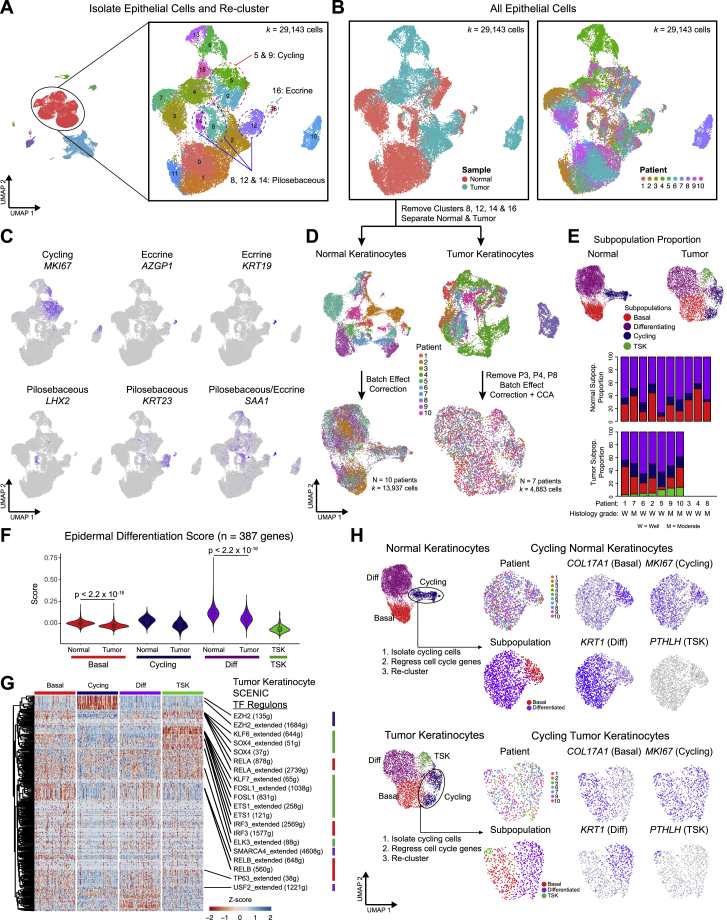
Keratinocyte Annotation and Subpopulation Analysis, Related to Figure 2(A) UMAP of all epithelial cell clusters (k = 29,143) with labeled cycling, eccrine cell, and pilosebaceous clusters. (B) UMAP of all epithelial cells labeled by tissue type and patient. (C) UMAP feature plots of expression of genes marking cycling, eccrine, or pilosebaceous clusters. (D) UMAPs of filtered normal and tumor keratinocytes labeled by patient before and after batch correction. CCA = canonical correlation analysis. (E) Bar plots showing proportion of each subpopulation across normal and tumor keratinocytes. (F) Violin plots of differentiation signature score (n = 387 genes, Lopez-Pajares et al., 2015) in normal and tumor keratinocyte subpopulations. p values were determined with pairwise Wilcoxon Rank Sum tests with Benjamini-Hochberg correction for multiple comparisons. (G) Clustered heatmap of all recovered transcription factor (TF) regulons from SCENIC analysis (n = 370 regulons) across tumor keratinocyte subpopulations. For visualization purposes, 100 random cells from each subpopulation are shown in the heatmap. (H) Cell cycle regression analysis with re-clustering into basal, differentiating, and TSK subpopulations with UMAP feature plots showing marker gene expression after cell cycle regression.